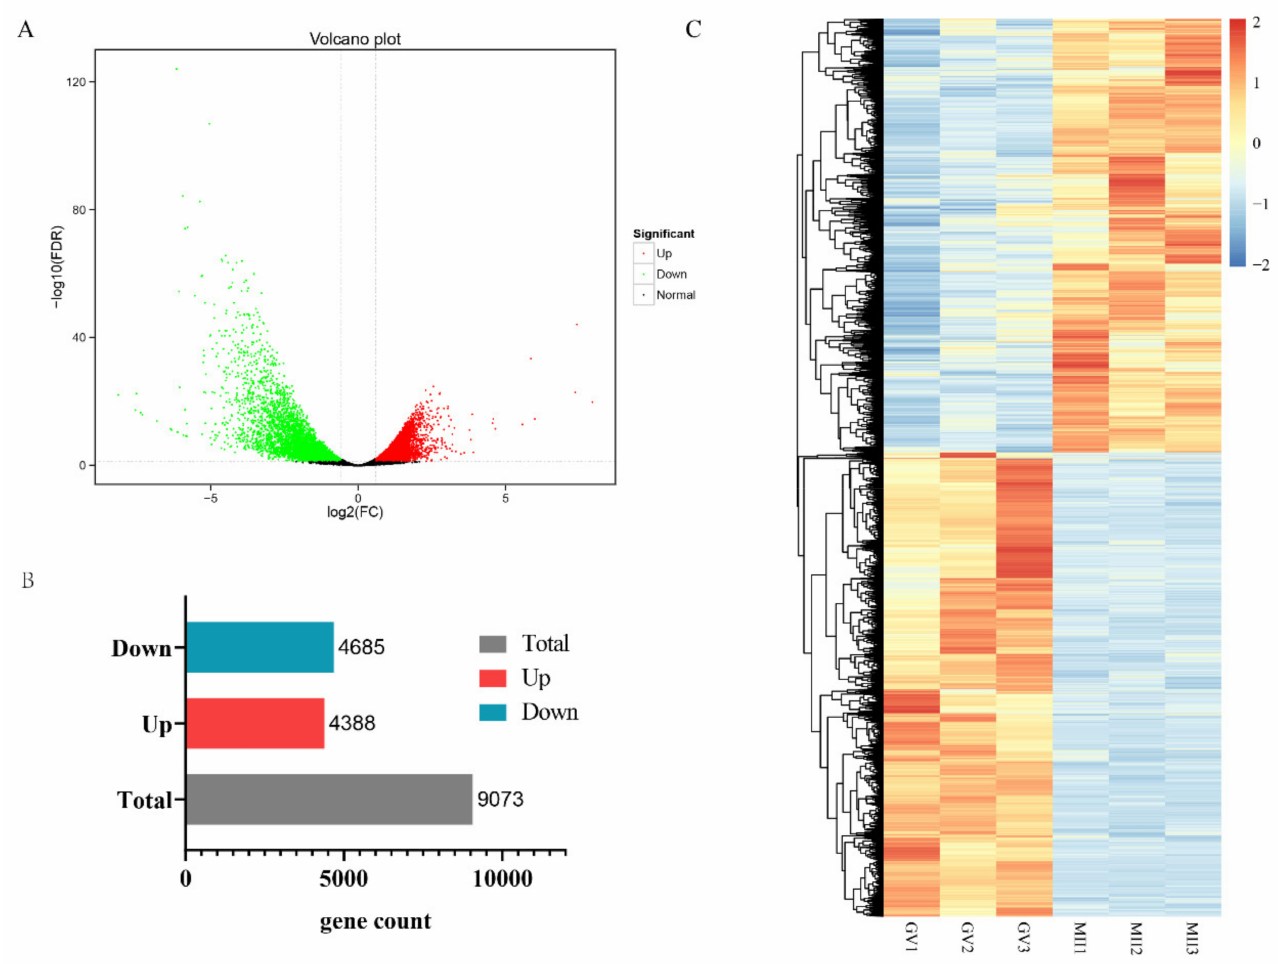
Figure 2. Differentially expressed gene (DEG) analysis. ( A ). Volcano plot for DEGs between GV and MII donkey oocytes (FDR < 0.05 and |log 2 (fold change)| ≥ 1.5); The red dots represent upregulated genes, and the blue dots represent downregulated genes. ( B ). Bar chart showing the up-regulated DEGs and down-regulated DEGs. ( C ). Heatmap of all